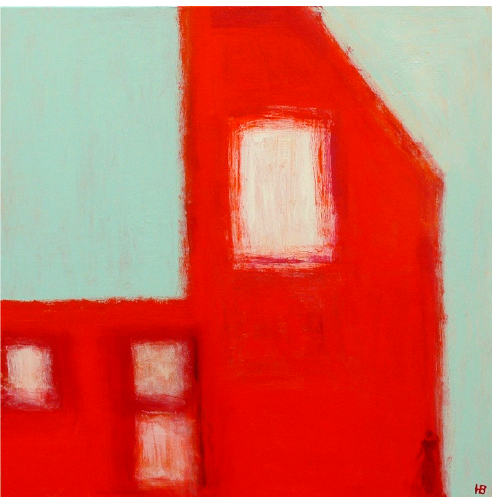
Figure 5. Hannah Bischof, “ Cardiazol ”, acrylic on canvas, Berlin 2015, © Ben Bischof.